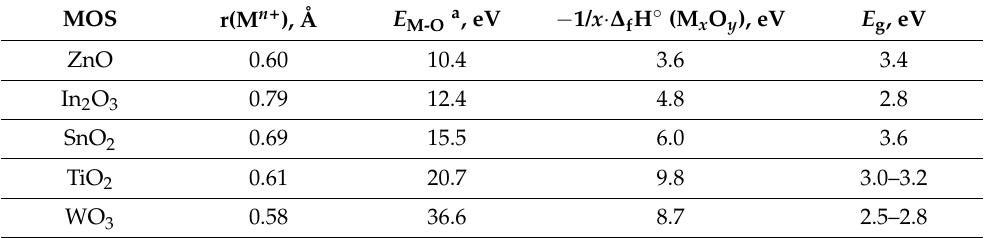
a Bond energy in metal oxides calculated from thermodynamic parameters [26]: E + x ·